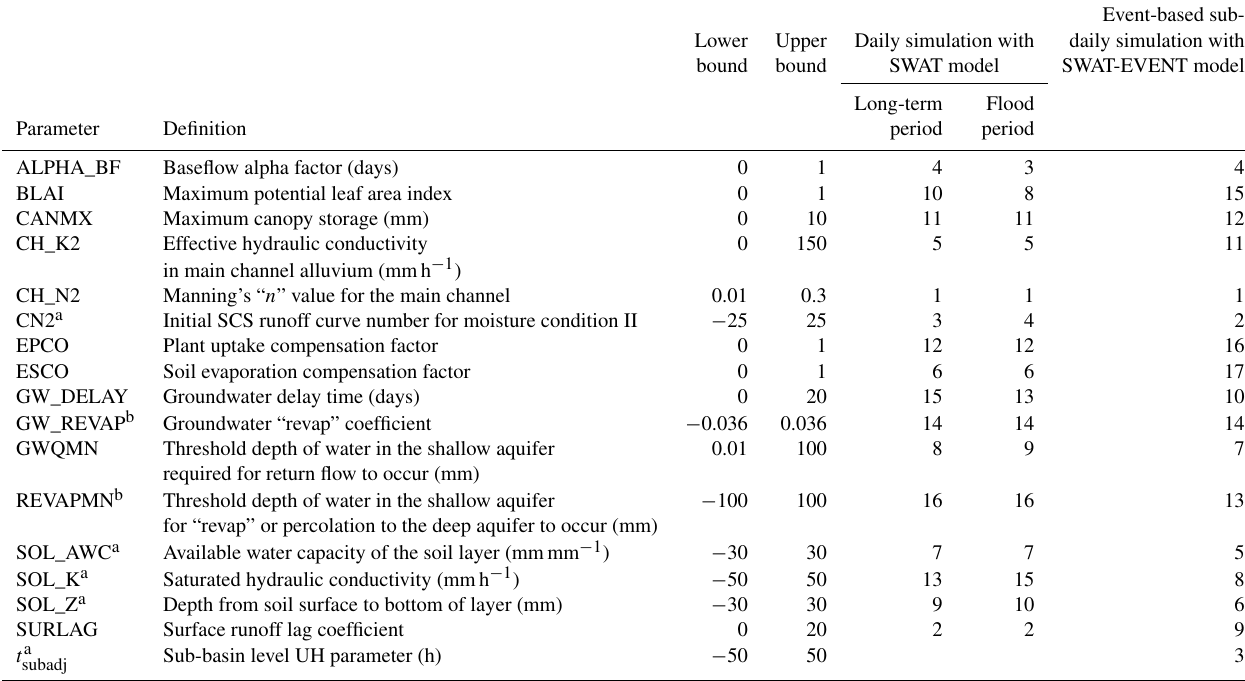
Table 3. Parameters and parameter ranges used in sensitivity analysis and the final ranks of sensitivity analysis results.